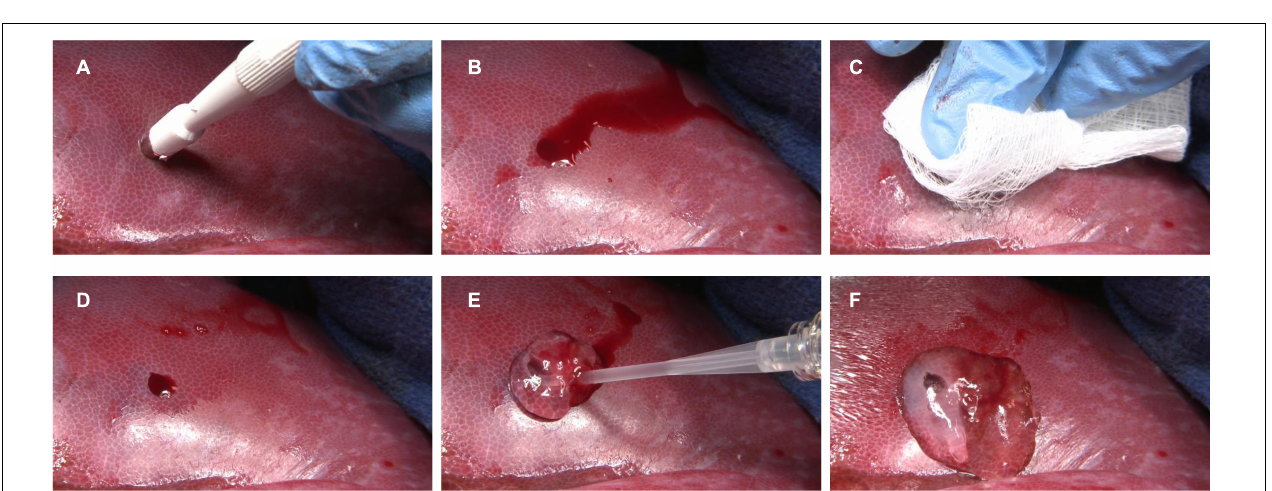
FIGURE 4 | Hemostatic use of RADA16 self-assembling peptide hydrogel to control bleeding from wound surfaces of the liver. In a porcine model, punch biopsy of the liver surface (A) results in frank bleeding (B) . After site irrigation and drying (C) , residual bleeding (D) is stopped by the easy single-syringe application of RADA16 solution (E) , which rapidly forms a transparent hemostatic in situ hydrogel barrier upon contact with physiological fluids (F) . This approach can be used to stop topical bleeding at surgical and wound sites in skin, organs, vessels, and other